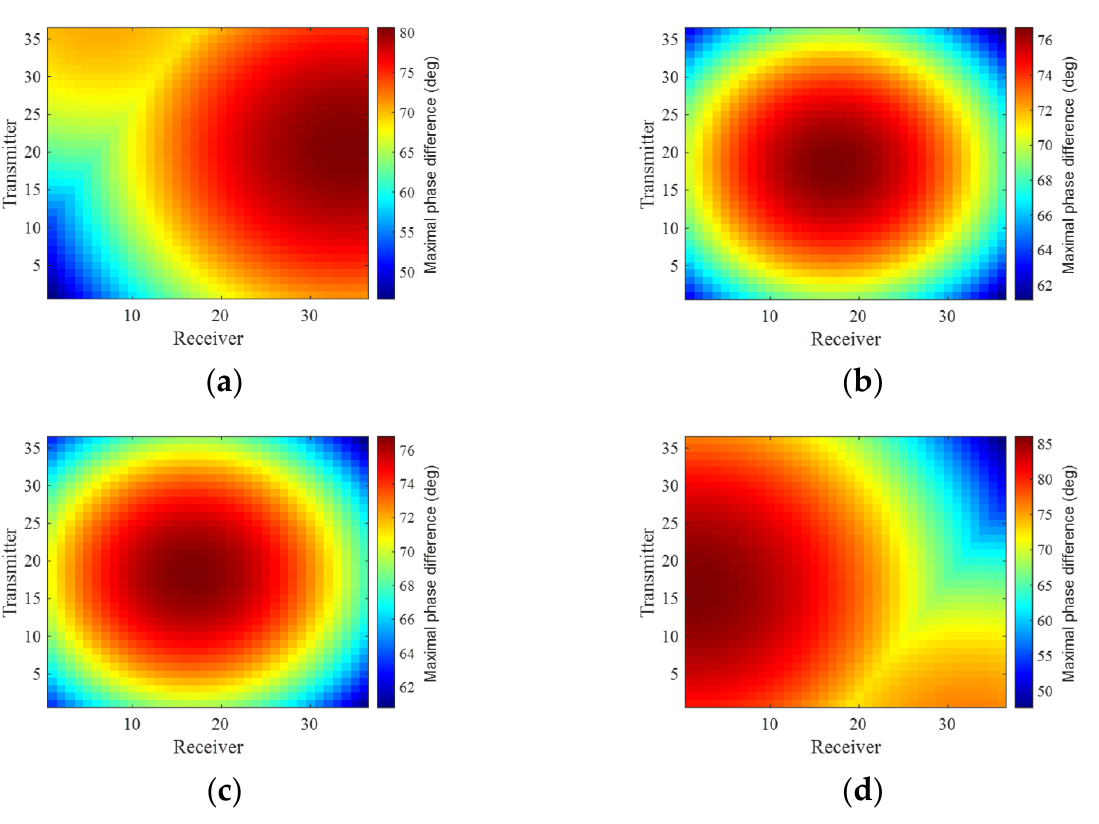
Figure 9. Maximal phase differences of all target-scattering centers for different transceiving antennas at ( a ) f 1 , ( b ) f 36 , ( c ) f 37 , and ( d ) f 72 .